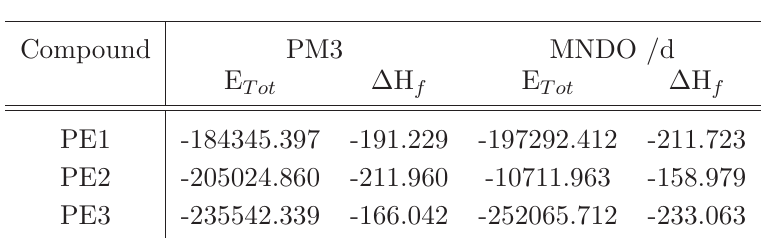
Table 6 Total energies and heats of formation of phosphinine-ether macrocycles (kcal/mol) given by Hyperchem program [41, 42].